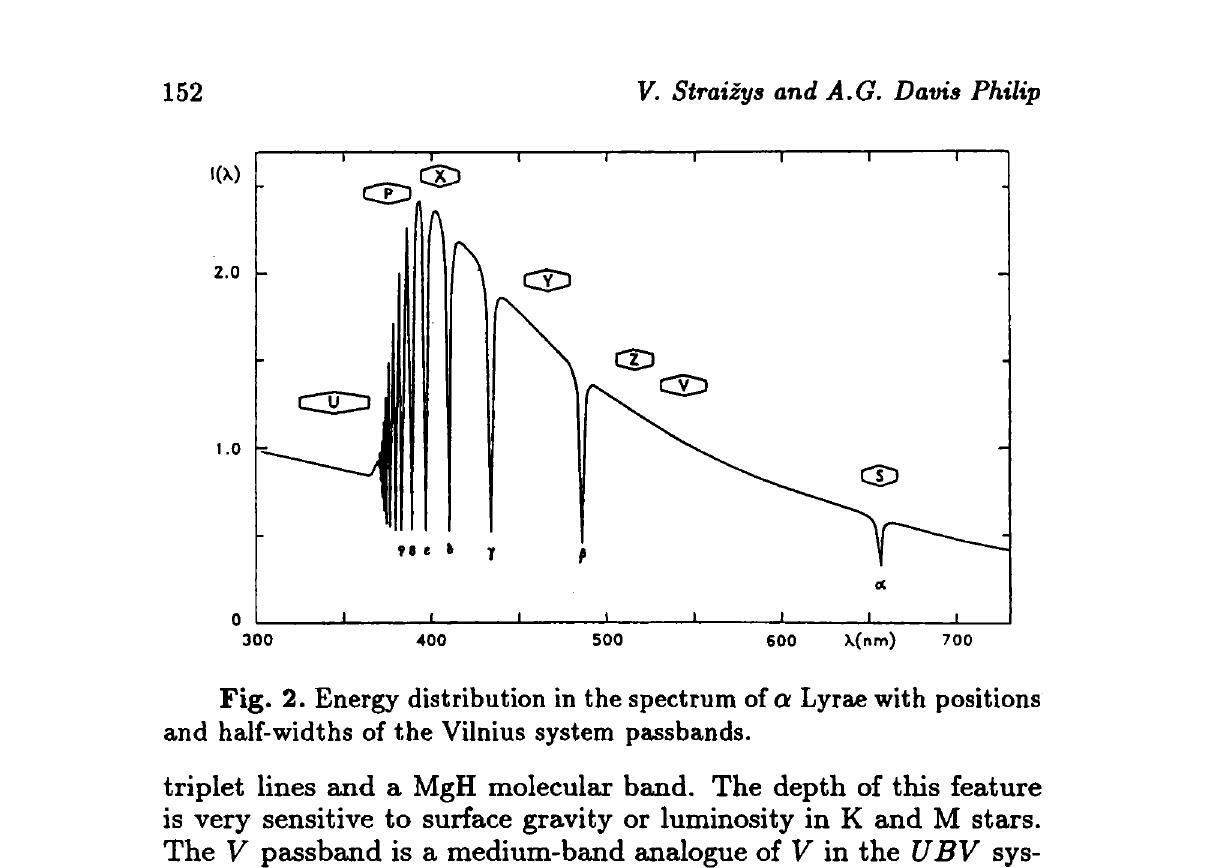
Fig. 2. Energy distribution in the spectrum of α Lyrae with positions and half-widths of the Vilnius system